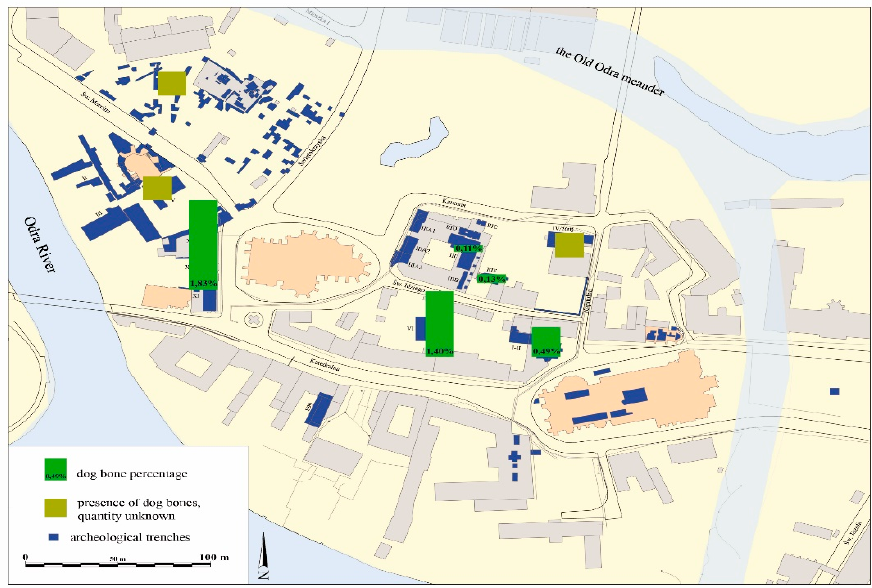
Figure 3. The stronghold in Wroclaw on Cathedral Island. Percentage of dog remains.